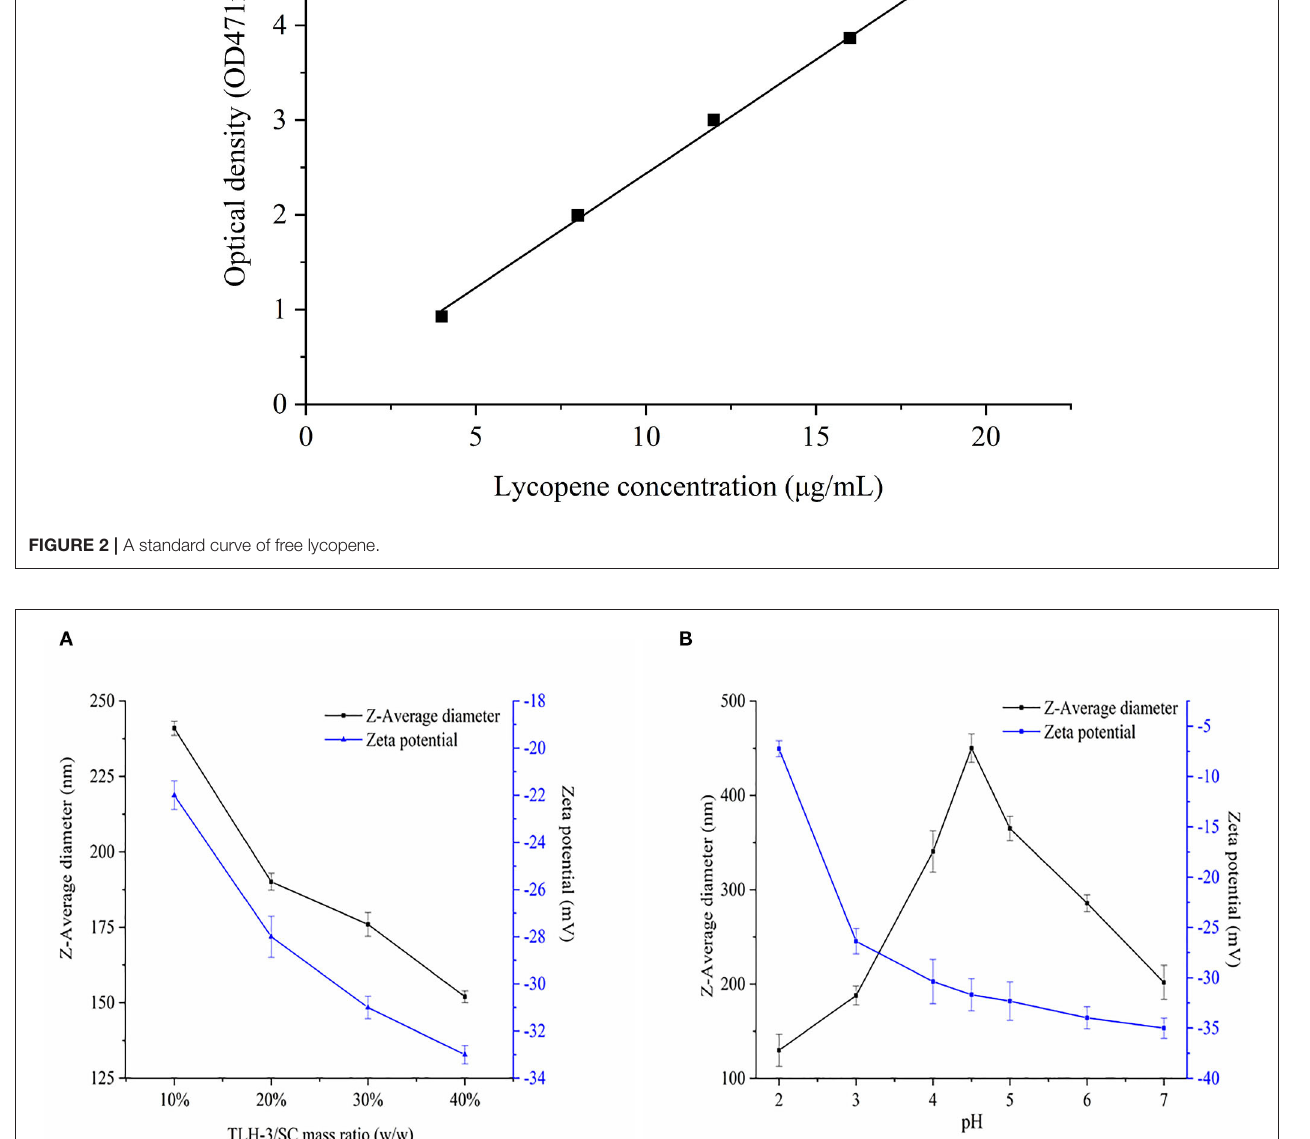
Frontiers in Nutrition |